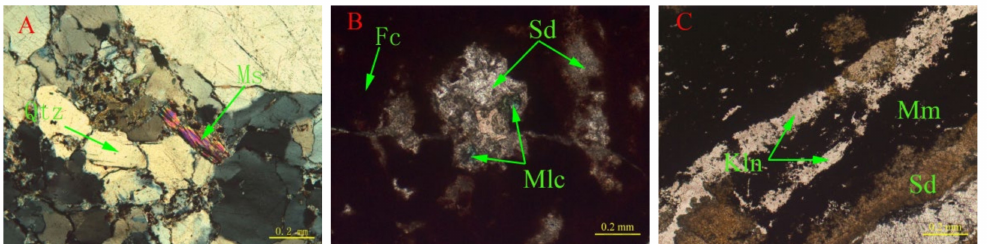
Figure 7. Images of main gangues (Abbreviations used: Qtz = Quartz, Ms = Muscovite, Sd = siderite, Mlc = Malachite, Fc = Ferruginous clay, Kln = Kaolinite and Mm = Metal minerals. Green arrows indicate minerals). The ( A – C ) subfigures show the microscope images of gangue and other minerals in the